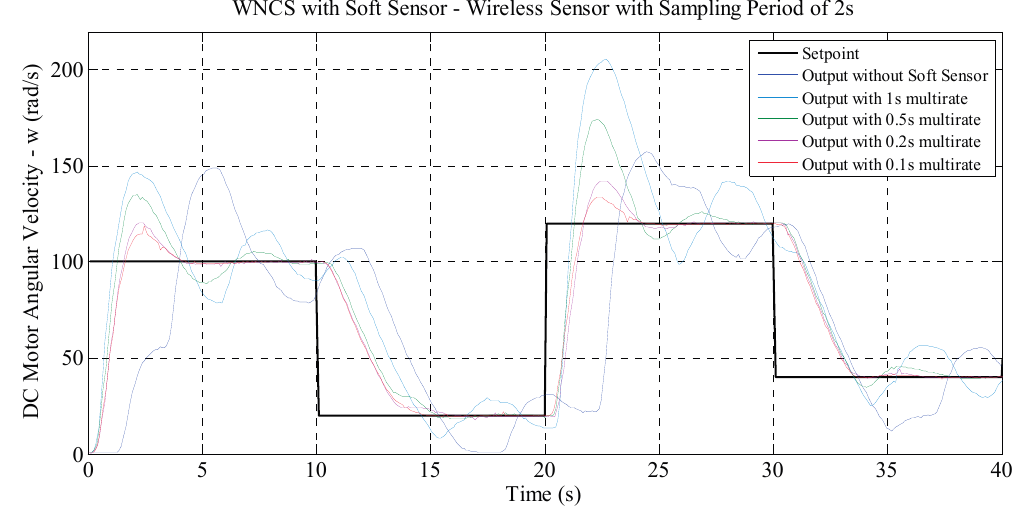
Figure 6. Comparison between the WNCS responses: wireless sensor with real sampling period of 2 s and soft sensor with virtual data sampling period of 1, 0.5, 0.25 and 0.1 s.